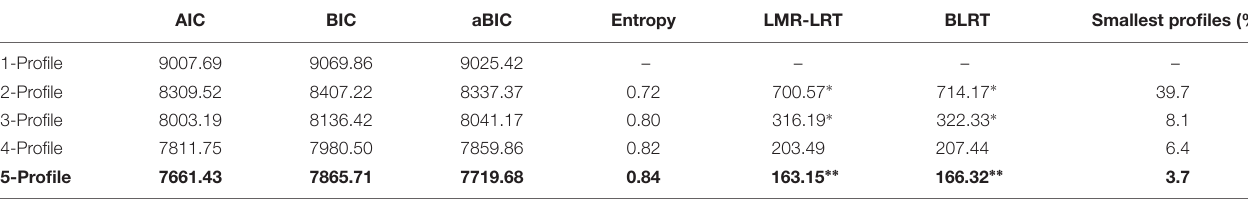
TABLE 2 | The goodness of fit indices for different latent psychosocial adjustment profiles. AIC BIC aBIC Entropy LMR-LRT